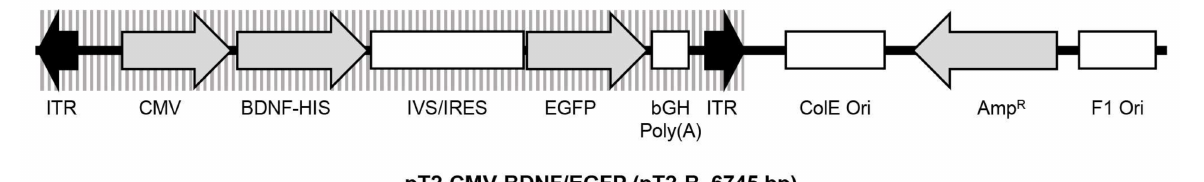
Figure 10. Schematic drawing of the transposon plasmid pT2-CMV-BDNF/EGFP. The plasmid is based on pT2/HB and has a size of 6745 base pairs. The expression cassette is flanked by inverted terminal repeats (ITRs) and contains a human BDNF cDNA expressed under control of the CMV promoter and fused to a 6x histidine-tag (HIS), followed by a pIRES-EGFP-vector-derived synthetic intron (IVS) and an internal ribosomal entry site (IRES) which enable co-translation of BDNF and the enhanced green fluorescence protein